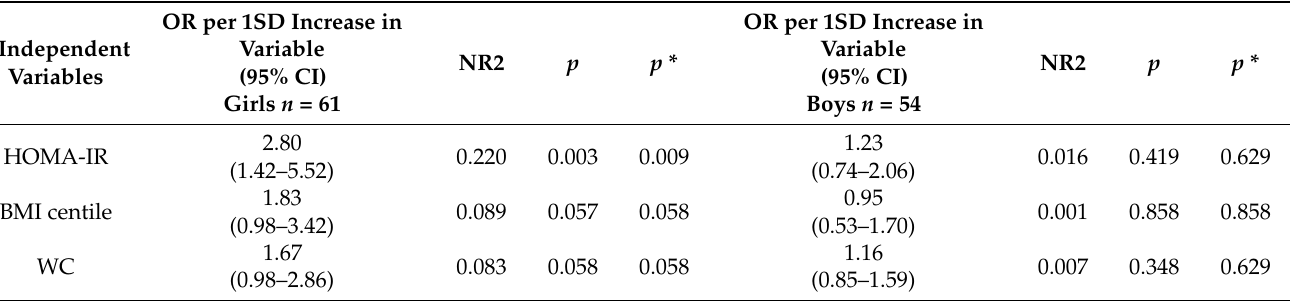
Table 5. Associations of metabolic risk factors with CTX-1 values below the median (<1.50 ng/mL) in univariate logistic regression models stratified by